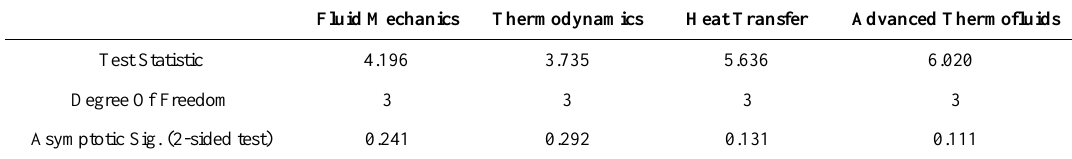
Table 2. Kruskal-Wallis tests for academic performance of students in four courses Fluid